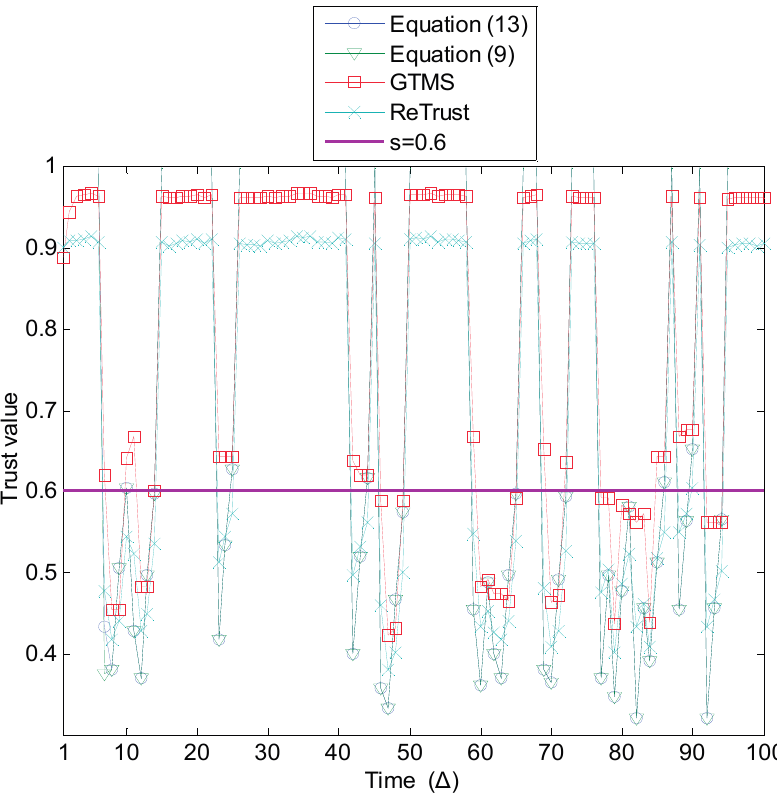
Figure 11. On-off attack detection (probability of an on period is 0.2).